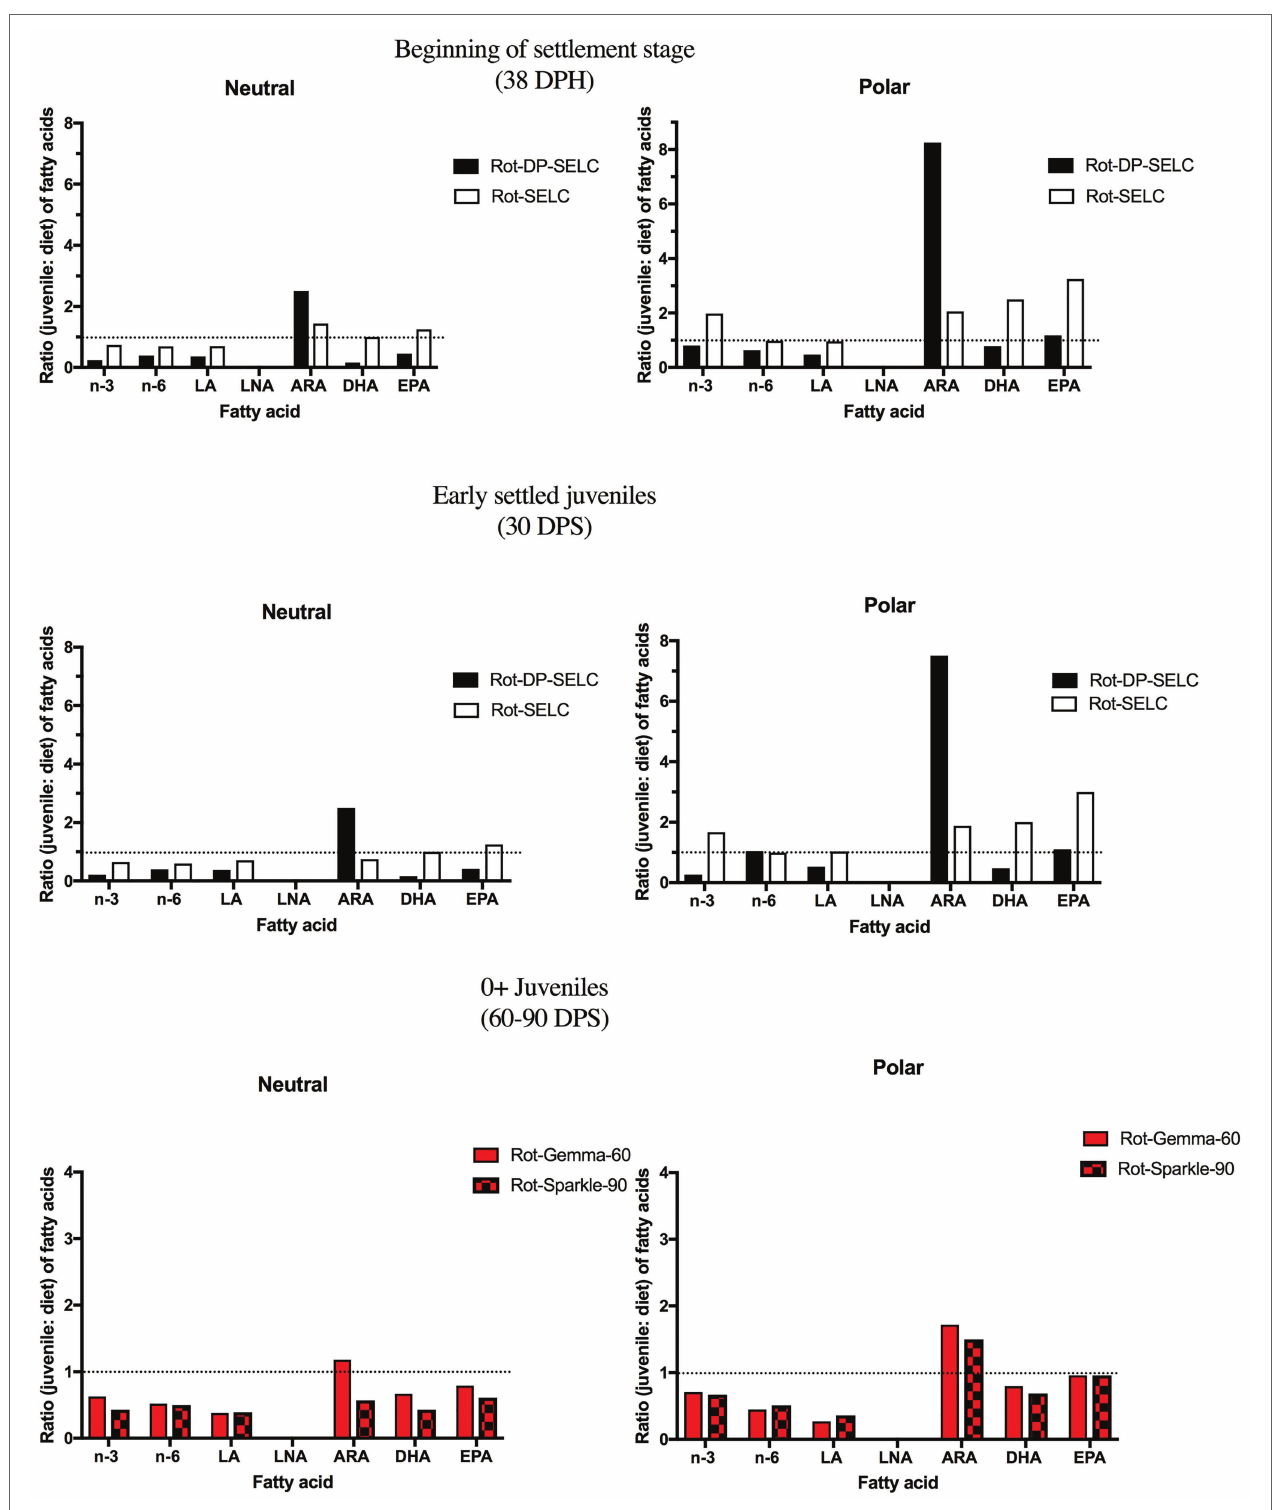
FIGURE 5 | Ratio of neutral or polar fatty acids in winter flounder ( P. americanus ) juveniles relative to diet total fatty acids contents (juvenile: diet) at the beginning of settlement (38 DPH), early settled juveniles [30 days post settlement (DPS)], and 0+ juveniles (60–90 DPS) fed several enriched rotifer diets: Selco 3000 (Rot-SELC), DHA Protein Selco (DP-SELC), sparkle-INVE (Rot-Sparkle), and Gemma microdiet (Rot+Gemma). The dashed lines (ratio = 1) indicate equal amounts of fatty acids in the juveniles and in the diet. LA, linoleic acid; LNA, linolenic acid; ARA, arachidonic acid; DHA, docosahexaenoic acid; and EPA, eicosapentaenoic